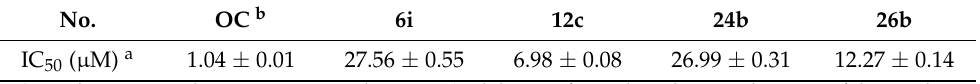
Table 2. Inhibitory activity of 6i , 12c , 24b , and 26b against clinically isolated A/H3N2 NA ( µ M) a .